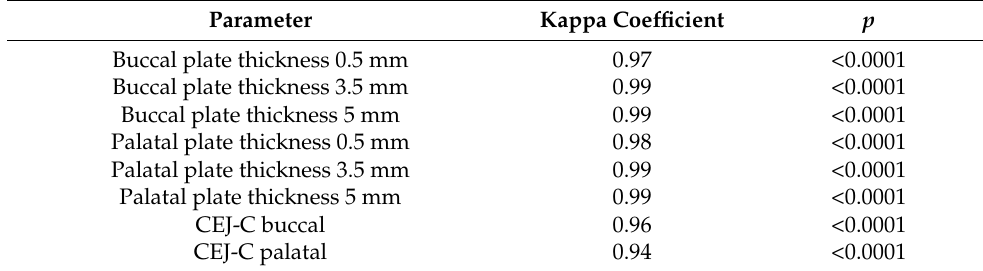
Table 10. Intraexaminer reliability of radiographic